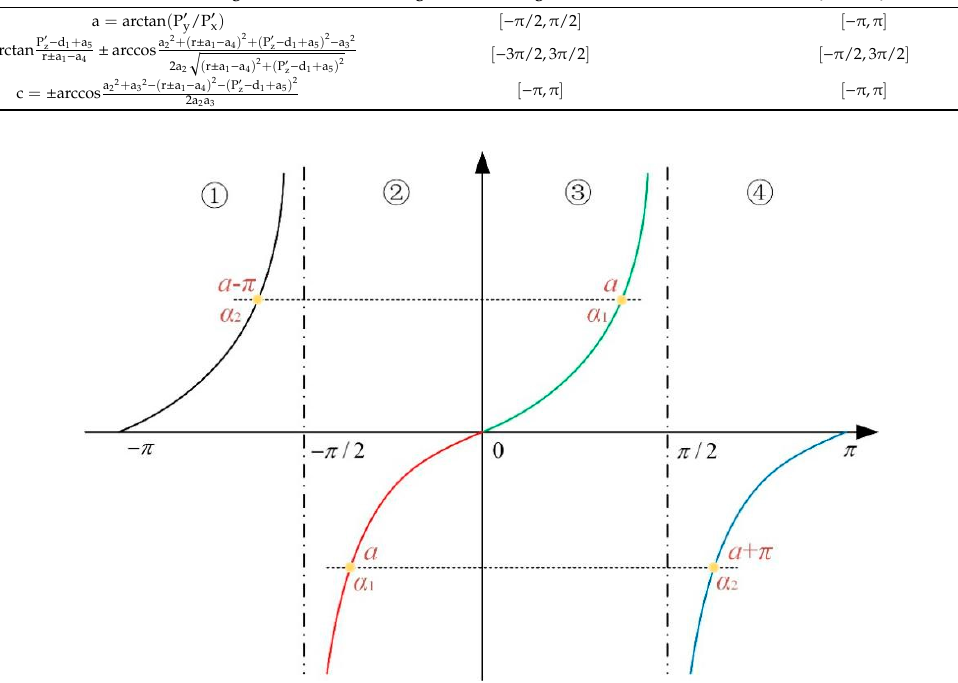
Range of Stroke of A- Inverse Joint, B-Joint, Trigonometric or C-Joint Functions  Table 2. The solutions of the joint angle of the A-joint. '